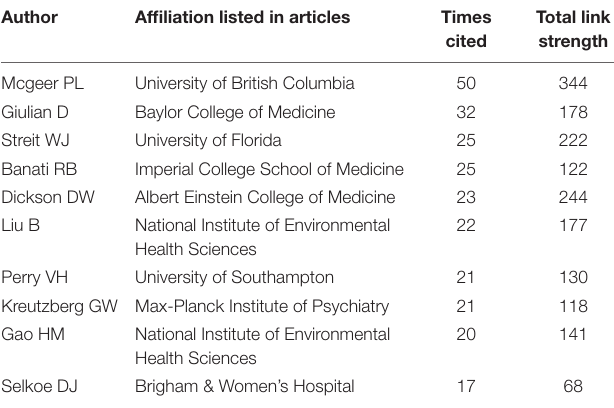
TABLE 3 | List of the top 10 cited authors in the references.